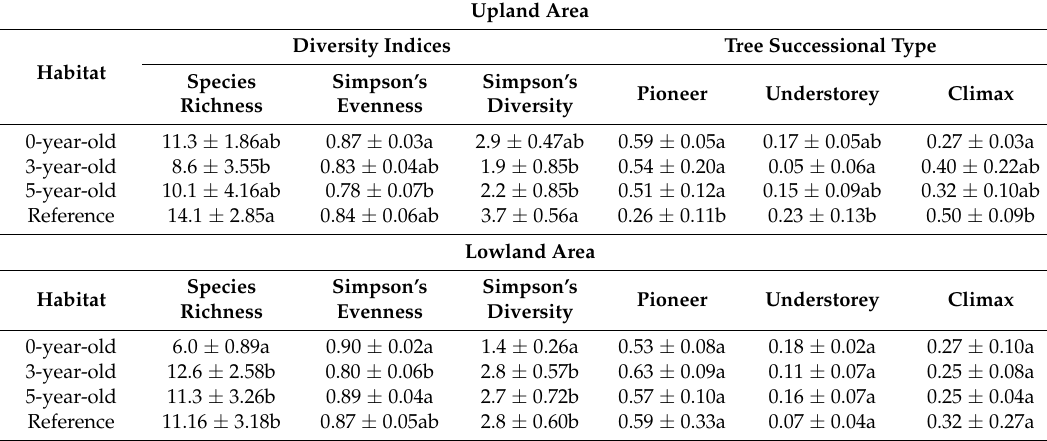
Table 1. Measures of species richness, diversity and species successional type proportion across habitats (mean ±